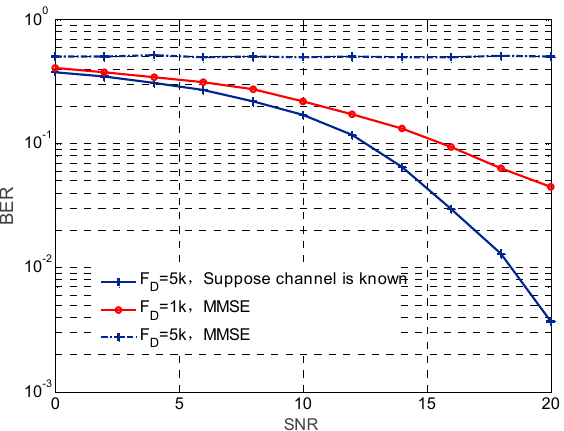
Figure 4. Bit error rate (BER) performance under two typical normalized Doppler frequency offsets F D T .